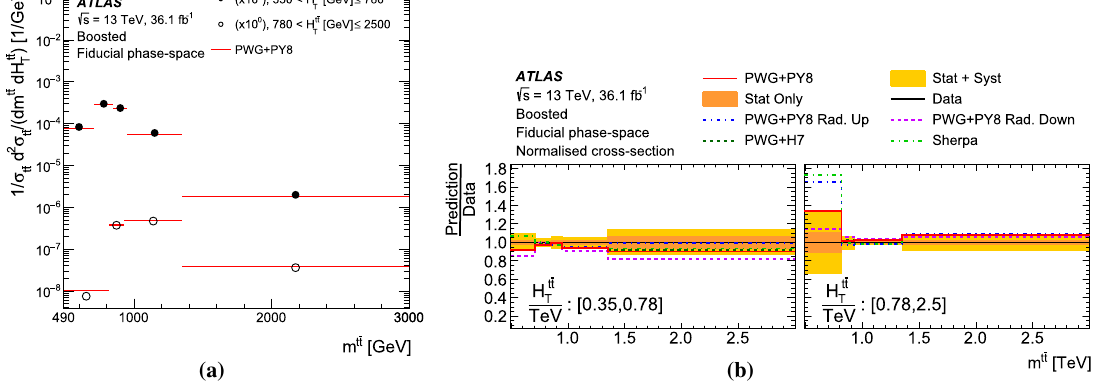
Fig. 46 a Particle-levelnormaliseddifferentialcross-sectionasafunc- inbins ofthemassofthe t ¯ t systeminthe boostedtopology tionof p t , had T compared with the prediction obtained with the Powheg + Pythia8 MC